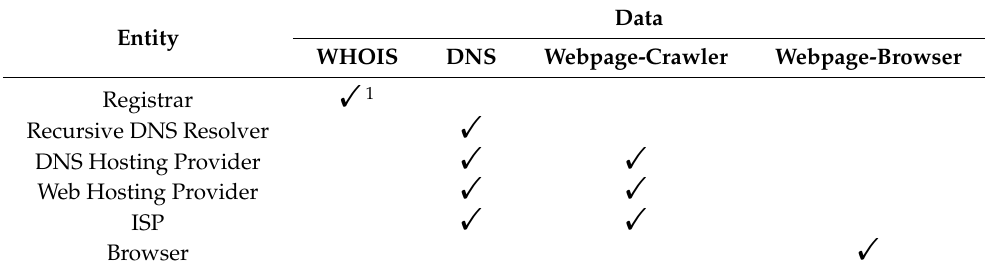
Table 3. Data on each dimension of the abusive domain names corresponding to the Internet